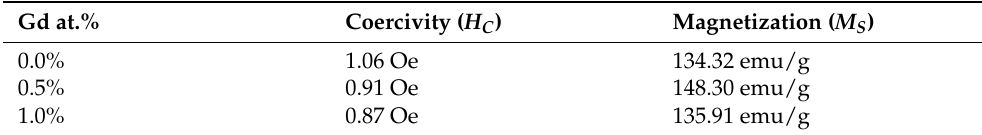
Table 4. Magnetic properties measured from VSM (as-cast alloys).